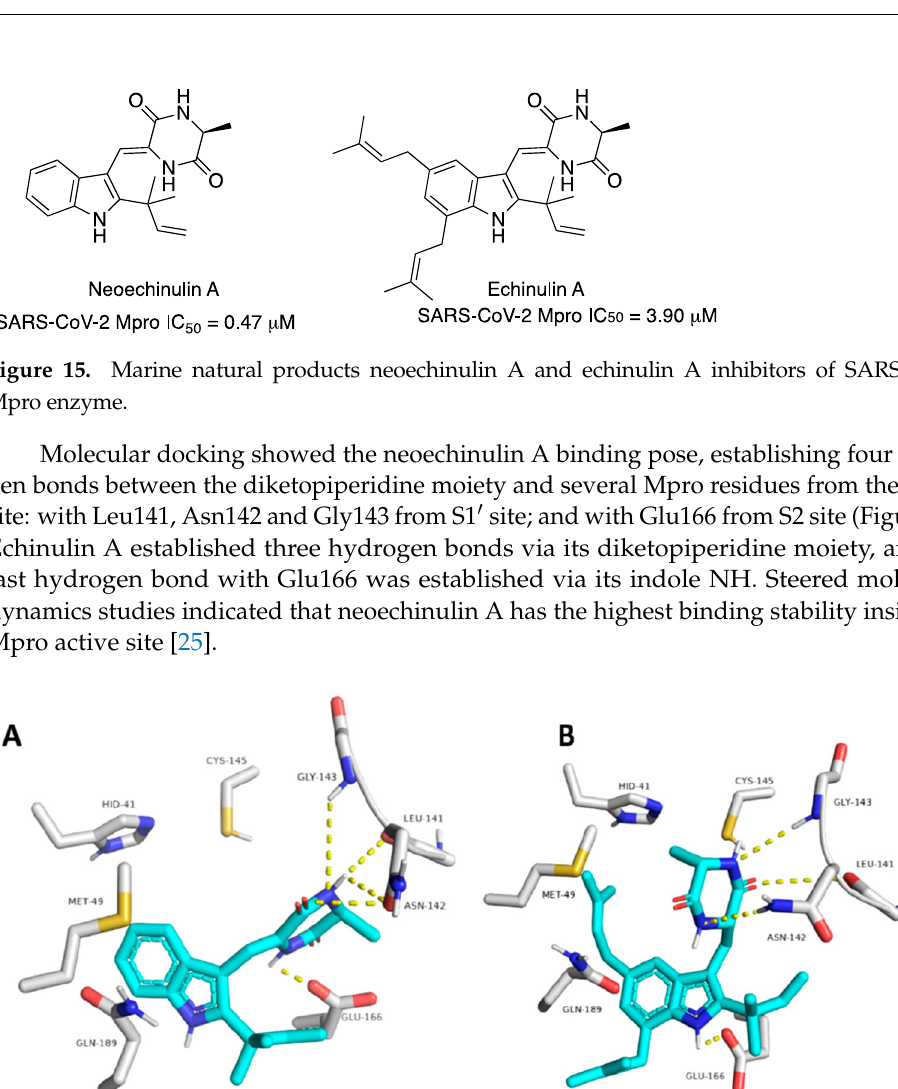
Figure 16. Binding poses of neoechinulin A and echinulin A into the active site of SARS ‐ CoV ‐ 2 Mpro enzyme ( A and B , respectively, images from [25]).